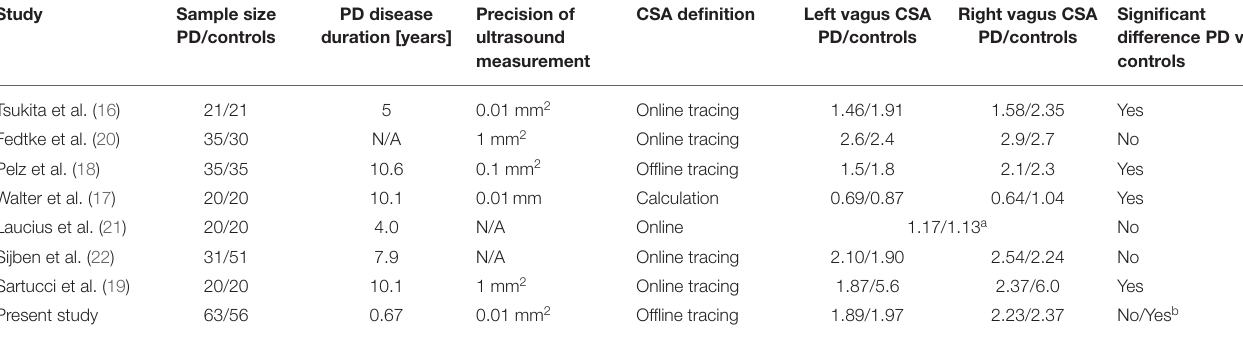
TABLE 2 | Published ultrasound studies of the vagus nerve in patients with Parkinson’s disease. Study Sample size